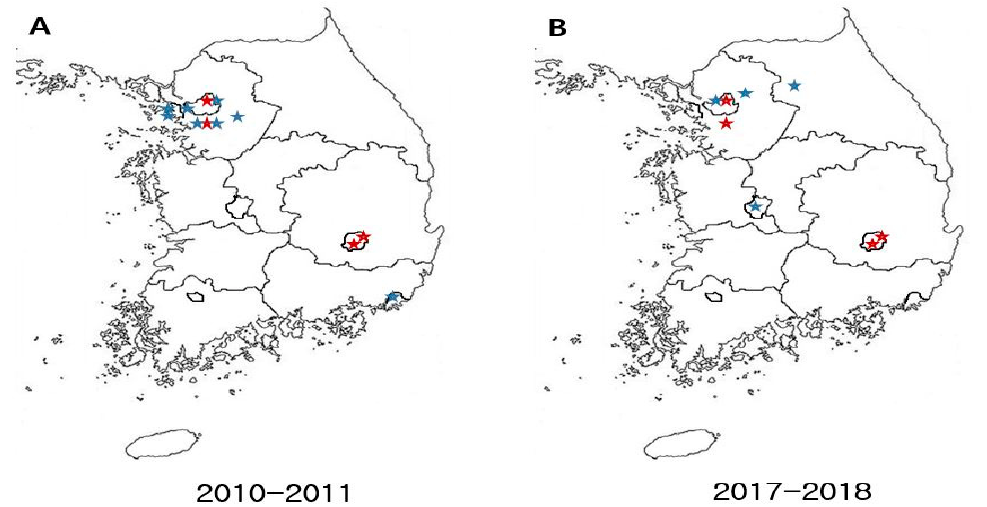
Figure 1. Geographic distribution of hospitals that participated in the study. Red stars indicate the hospitals that participated in both cohorts. ( A ) 11 hospitals for the study in 2010–2011, ( B ) 8 hospitals for the study in 2017–2018.